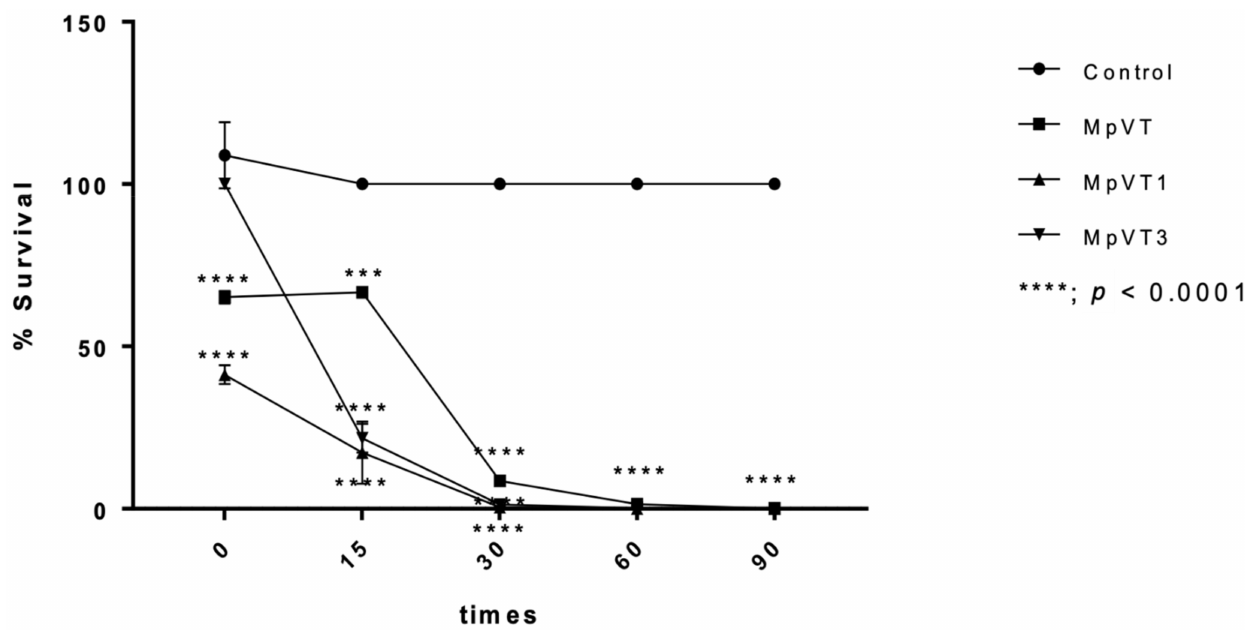
Figure 7. Time–kill kinetics of MpVT, MpVT1, MpVT3 and Control against E. coli 0157:H7 (open triangles) at a concentration two-fold above the MIC (100 µ g/mL). Controls correspond to bacteria incubated in PBS without peptide. Data are the means ± S.E.M. of one experiment performed in